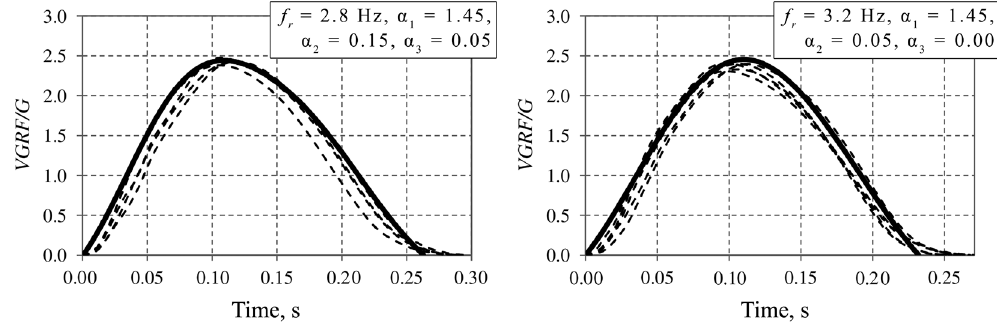
Figure 8. The normalised VGRF/G determined for f r = 2.8 Hz and f r = 3.2 Hz using Eq. (1) for adjusted input parameters (input parameters presented in the charts)